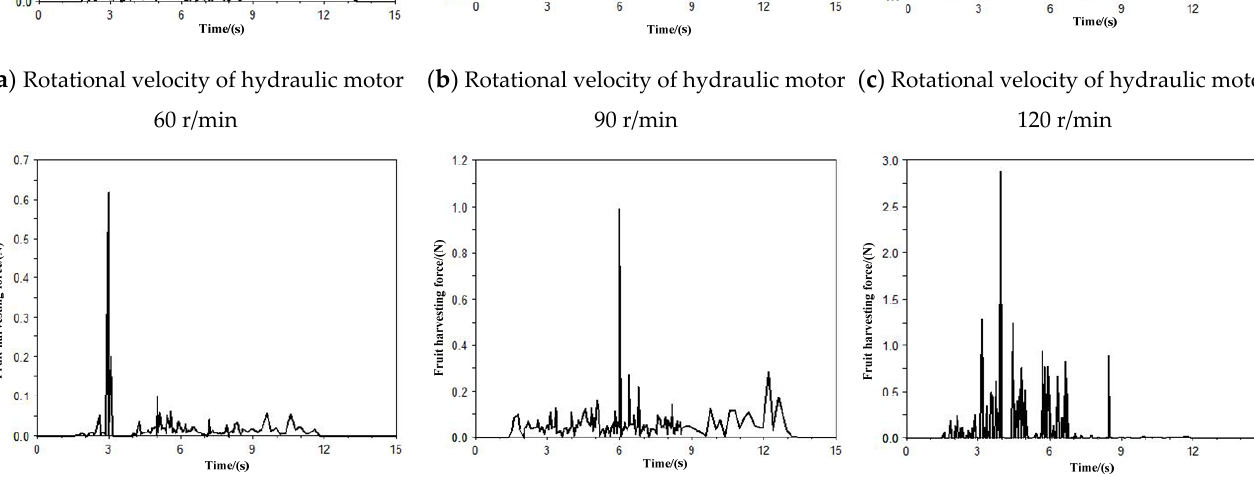
(𝑡) at the measurement point also increased, according to